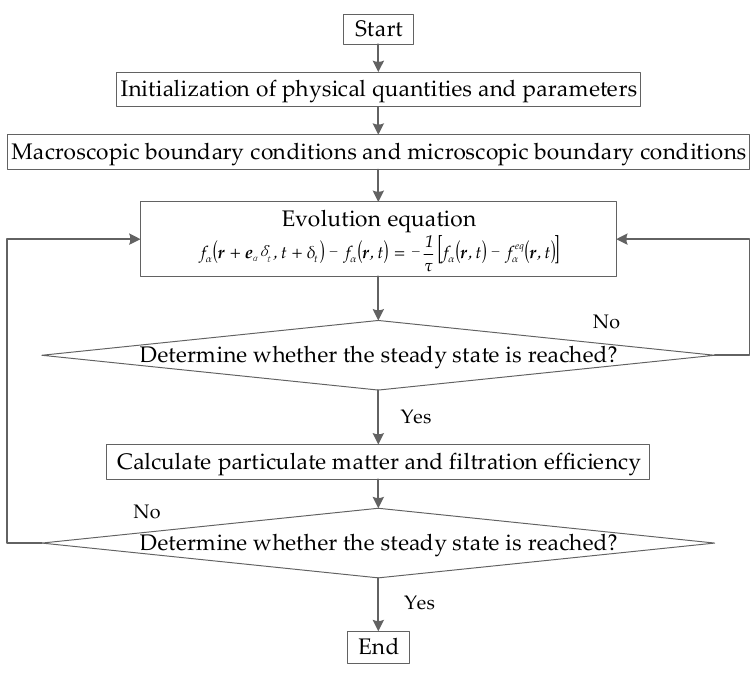
Figure 7. LB–CA model algorithmic flow chart.